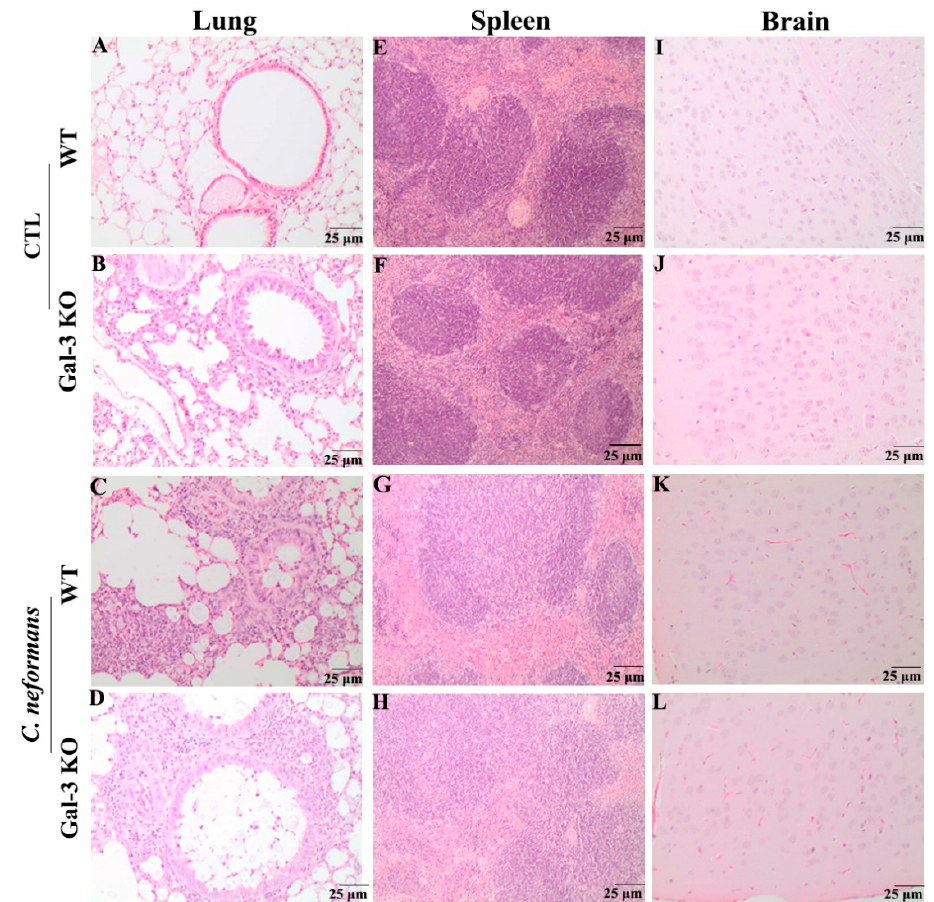
Figure 1. Histopathology of the lungs, spleens, and brains of the wild-type (WT) and Gal-3 knockout (KO) mice during the C. neoformans infection. Mice were intratracheally infected with 10 6 yeast cells or received PBS (control group-CTL), and their organs were analyzed seven days post-infection. The images represent the organs sections from WT and Gal-3 KO mice in the presence or absence of C. neoformans infection. In lungs, the absence of infection promoted higher mucus secretion in Gal-3 KO mice compared to the WT mice ( A , B ), whereas in cryptococcosis there was moderate peribronchial eosinophilia in both the WT and Gal-3 KO animals ( C , D ). Significant alterations were not detected in the spleens and brain ( E – L ). Tissue sections were stained with hematoxylin/eosin and the images were captured with an Olympus microscope equipped with a photo-documentation system. Scale bar = 25 µm for all organs. The slides shown are representative of ten samples per treatment group.